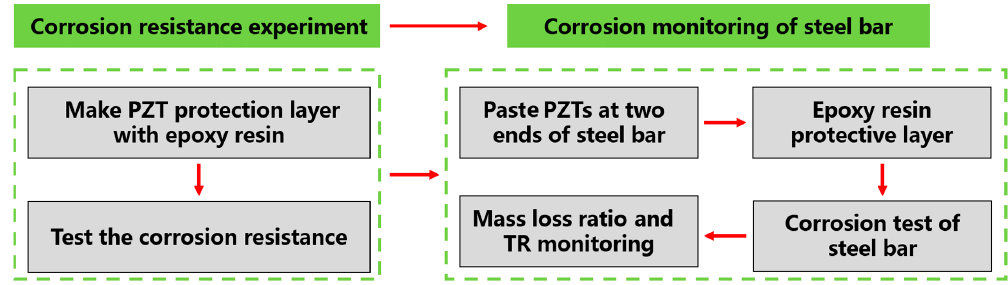
Figure 1. The flow chart of steel bar corrosion monitoring. PZT—lead zirconate